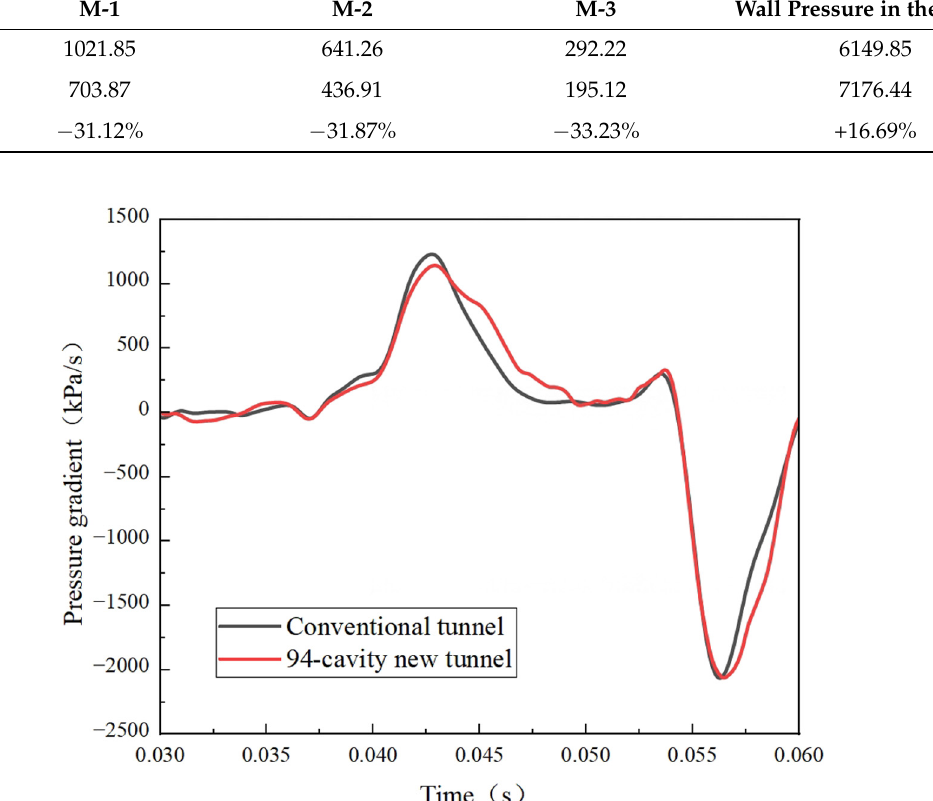
Figure 12. Initial compressional wave gradient comparison chart.